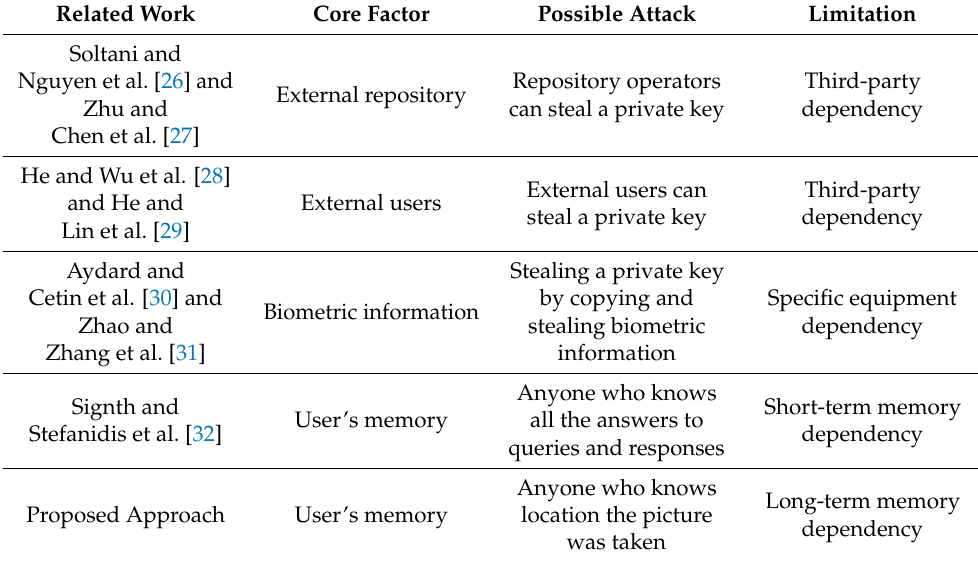
Table 1. Comparison of related